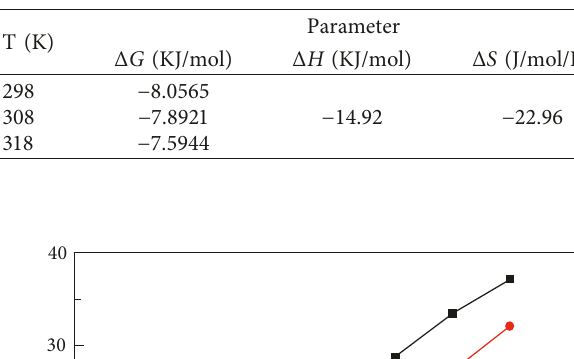
Table 4: Thermodynamic parameters for Cr (VI) removal by TGOM.